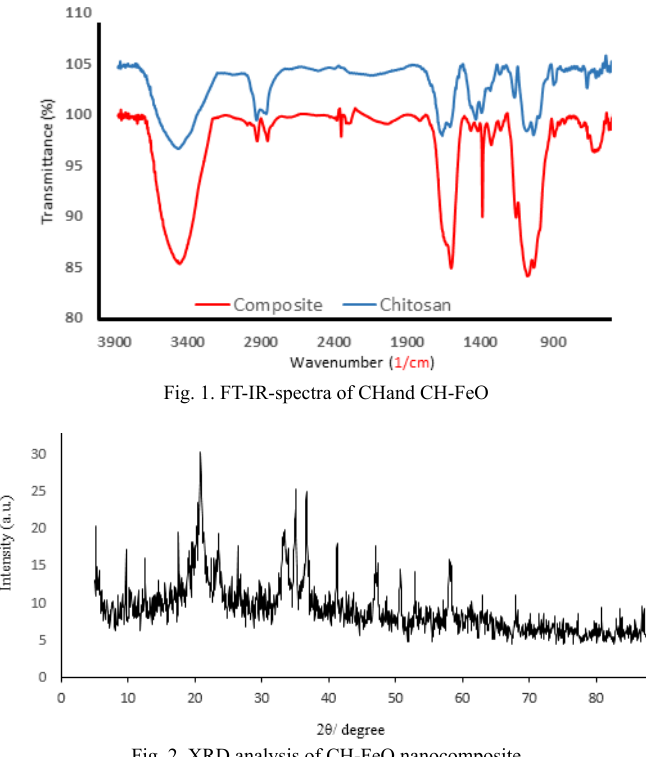
Fig. 2. XRD analysis of CH-FeO nanocomposite